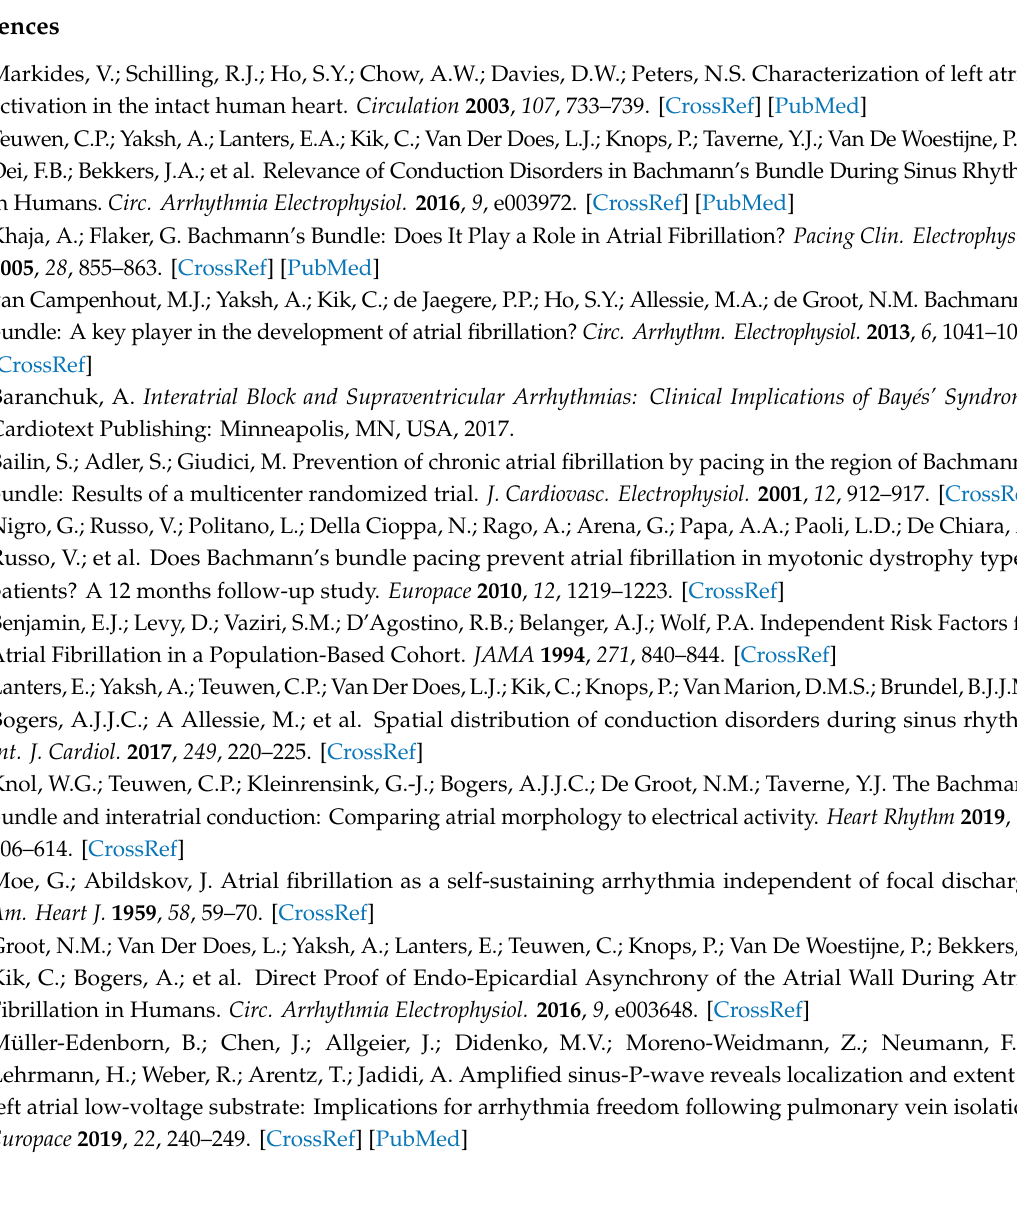
Table S1: Sub-analyses electrophysiological characteristics in patients with ischemic heart disease only, valvular heart disease only and ischemic and valvular heart disease